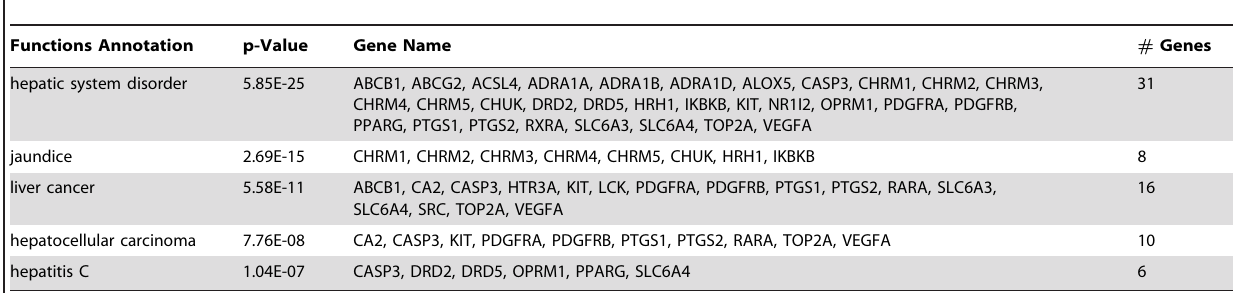
Table 3. Summary of significant functions and pathways for module # 1 identified in the network analysis of DILI targets using